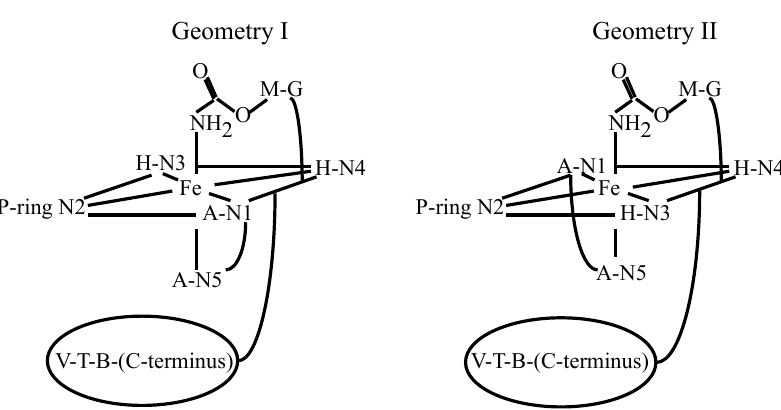
Figure 12. Coordination geometries tested for Fe(II)PEP